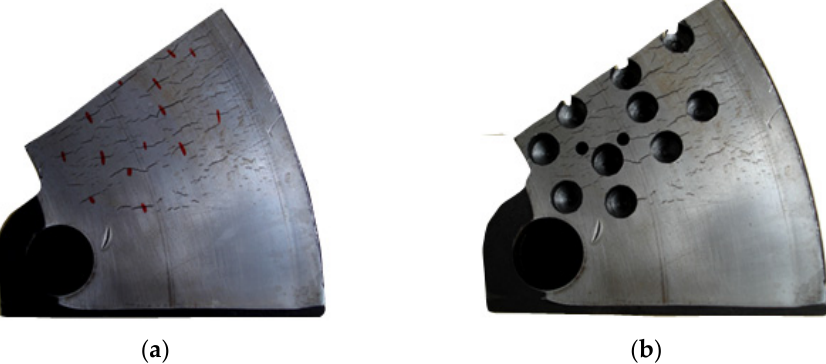
Figure 7. View of the 610 mm × 110 mm brake disc segment: ( a ) with the red half-crack line marked, ( b ) with blind holes to observe the crack depth.